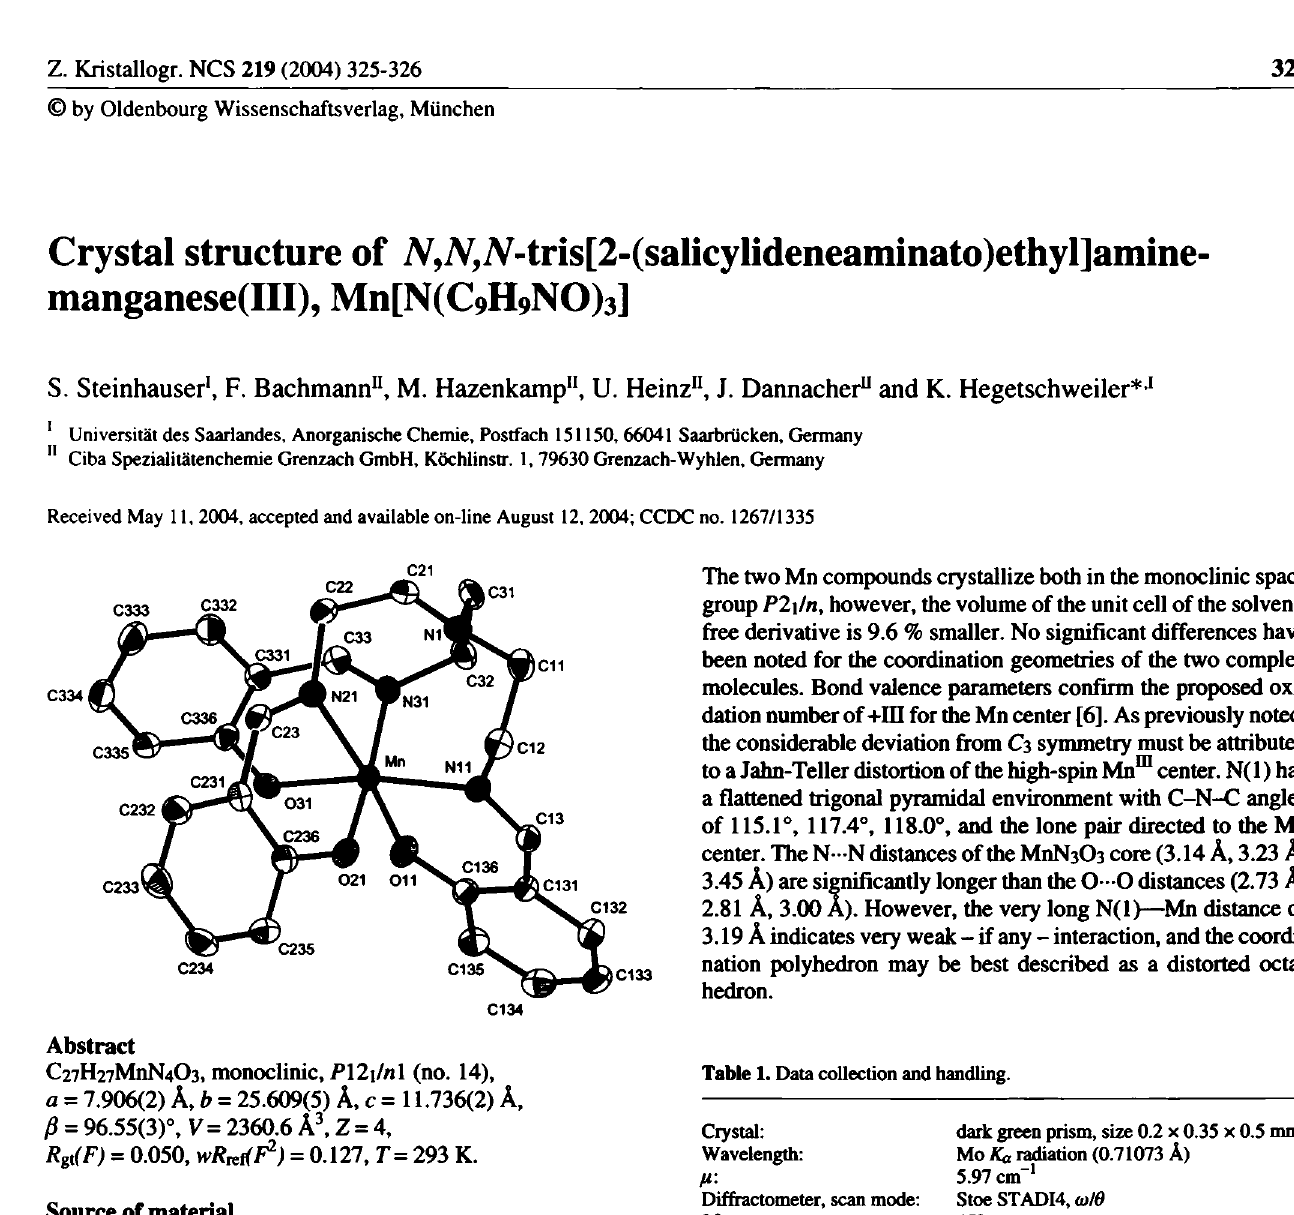
Table 2. Atomic coordinates and displacement parameters (in Ä 2